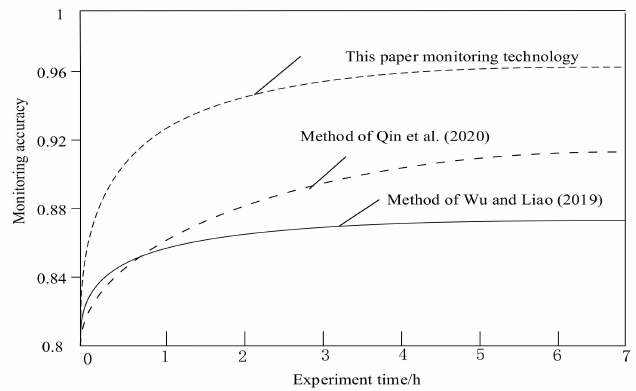
Figure 4. Comparison of monitoring